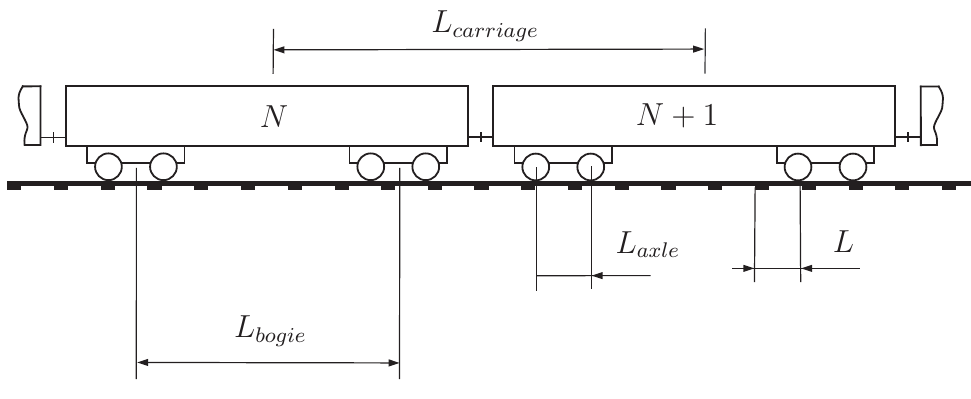
Figure 5. Rudimentary geometrical parameters of the train and the track